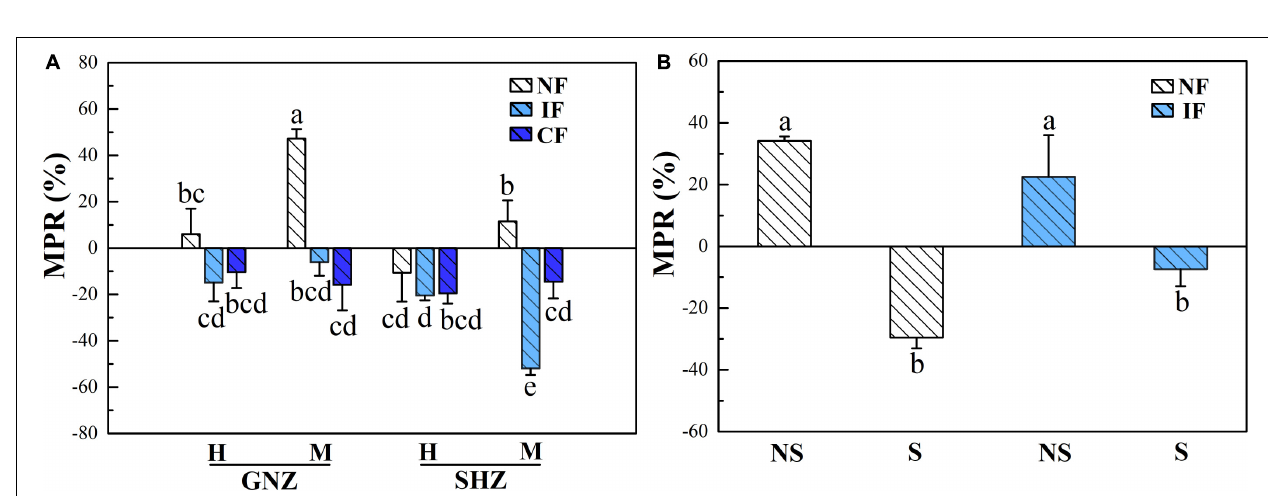
FIGURE 4 | Mycorrhizal phosphorus response (MPR) in Exp. 1 (A) and Exp. 2 (B) . Rice varieties are indicated as GNZ, Guinongzhan; SHZ, Sanhuangzhan. The rice varieties of GNZ and SHZ were used In Exp. 1, and SHZ was used in Exp. 2. Rice growth stages are indicated as H, Heading; and M, Maturing. Rice plants were harvested at the heading and maturing stages in Exp. 1 and harvested at the heading stage in Exp. 2. Flooding treatments are indicated as NF, Non-flooding; IF, Intermittent flooding; CF, Continuous flooding. Shading treatments are indicated as NS, Non-shading; S, Shading. Different letters above the columns indicate significant differences at the P < 0.05 level. Means and standard errors from three (A) and five replicates (B) are shown.